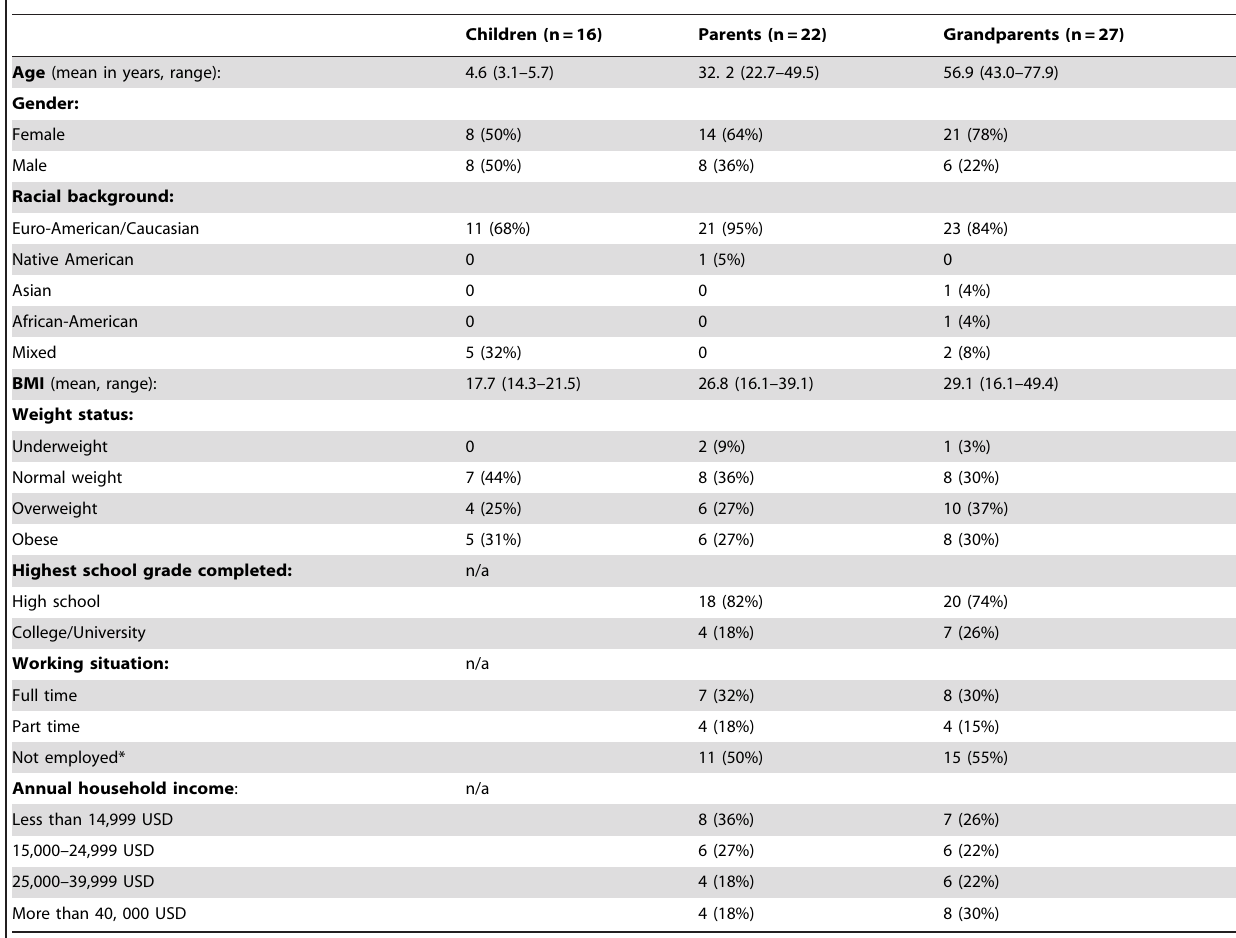
Table 1. Descriptive statistics of the